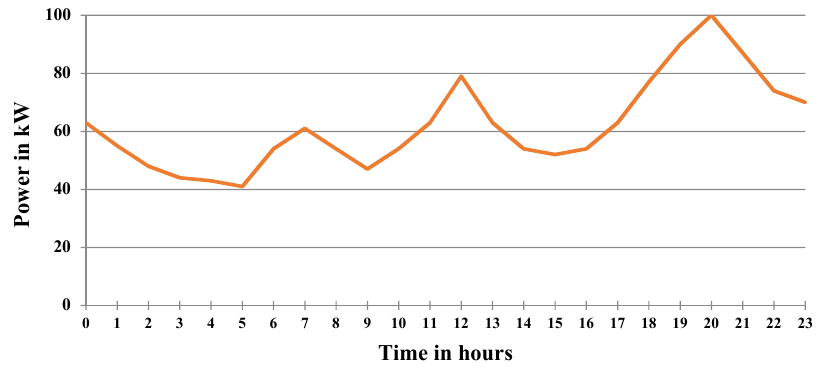
Figure 13. Daily load profile.